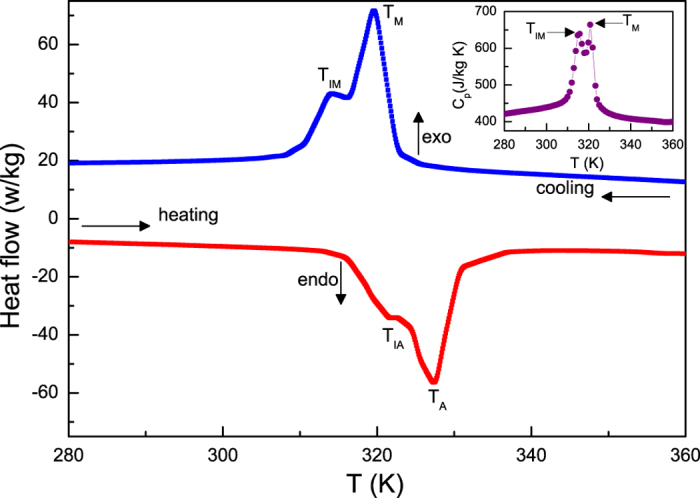
Heat flow data measured by continuous heating and cooling for Ni55.8Mn18.1Ga26.1 alloy.The inset shows temperature dependence of specific heat Cp(T) during cooling for this sample.